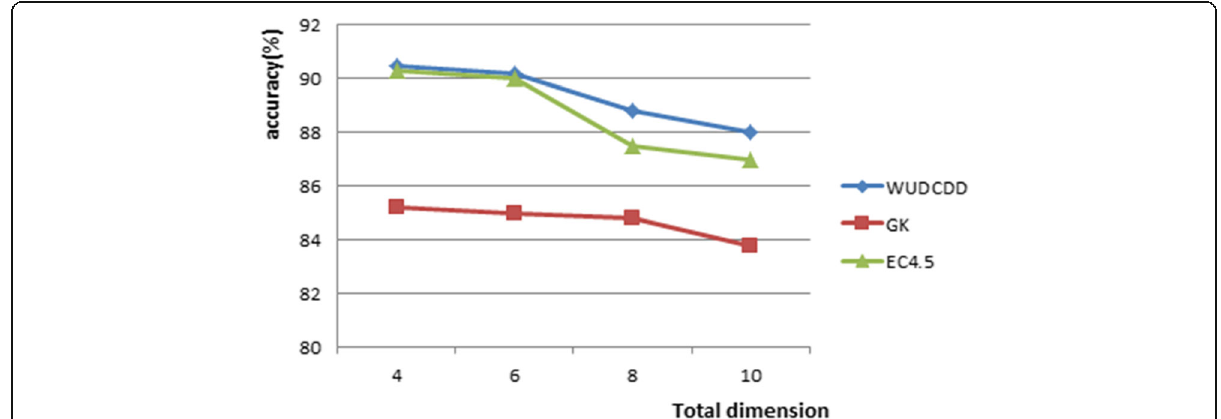
Fig. 4 The effect of the total number of dimensions on the